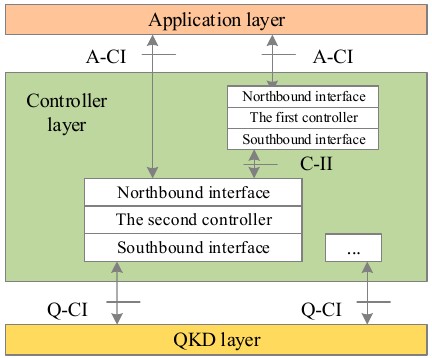
Figure 4. Related interfaces in QKD network enabled by SDN.